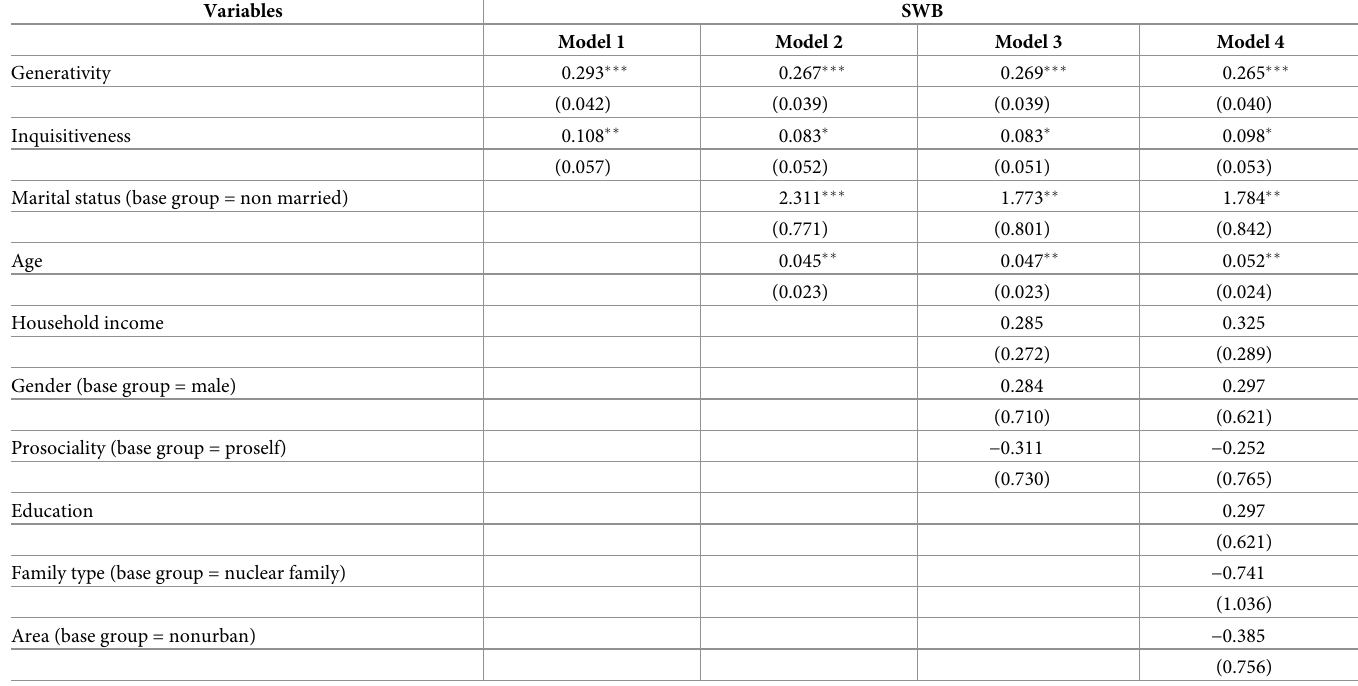
Table 4. Estimation results of median regression on subjective wellbeing